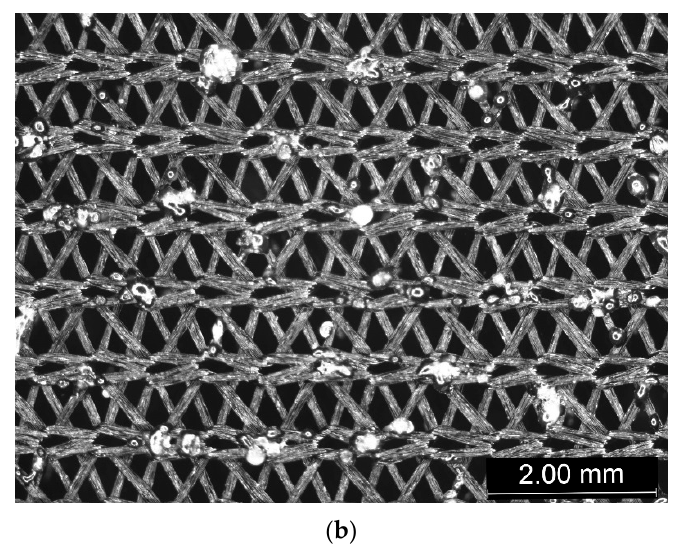
Figure 3. ( a ) Knitted interlining; ( b ) microscope views of knitted interlining.